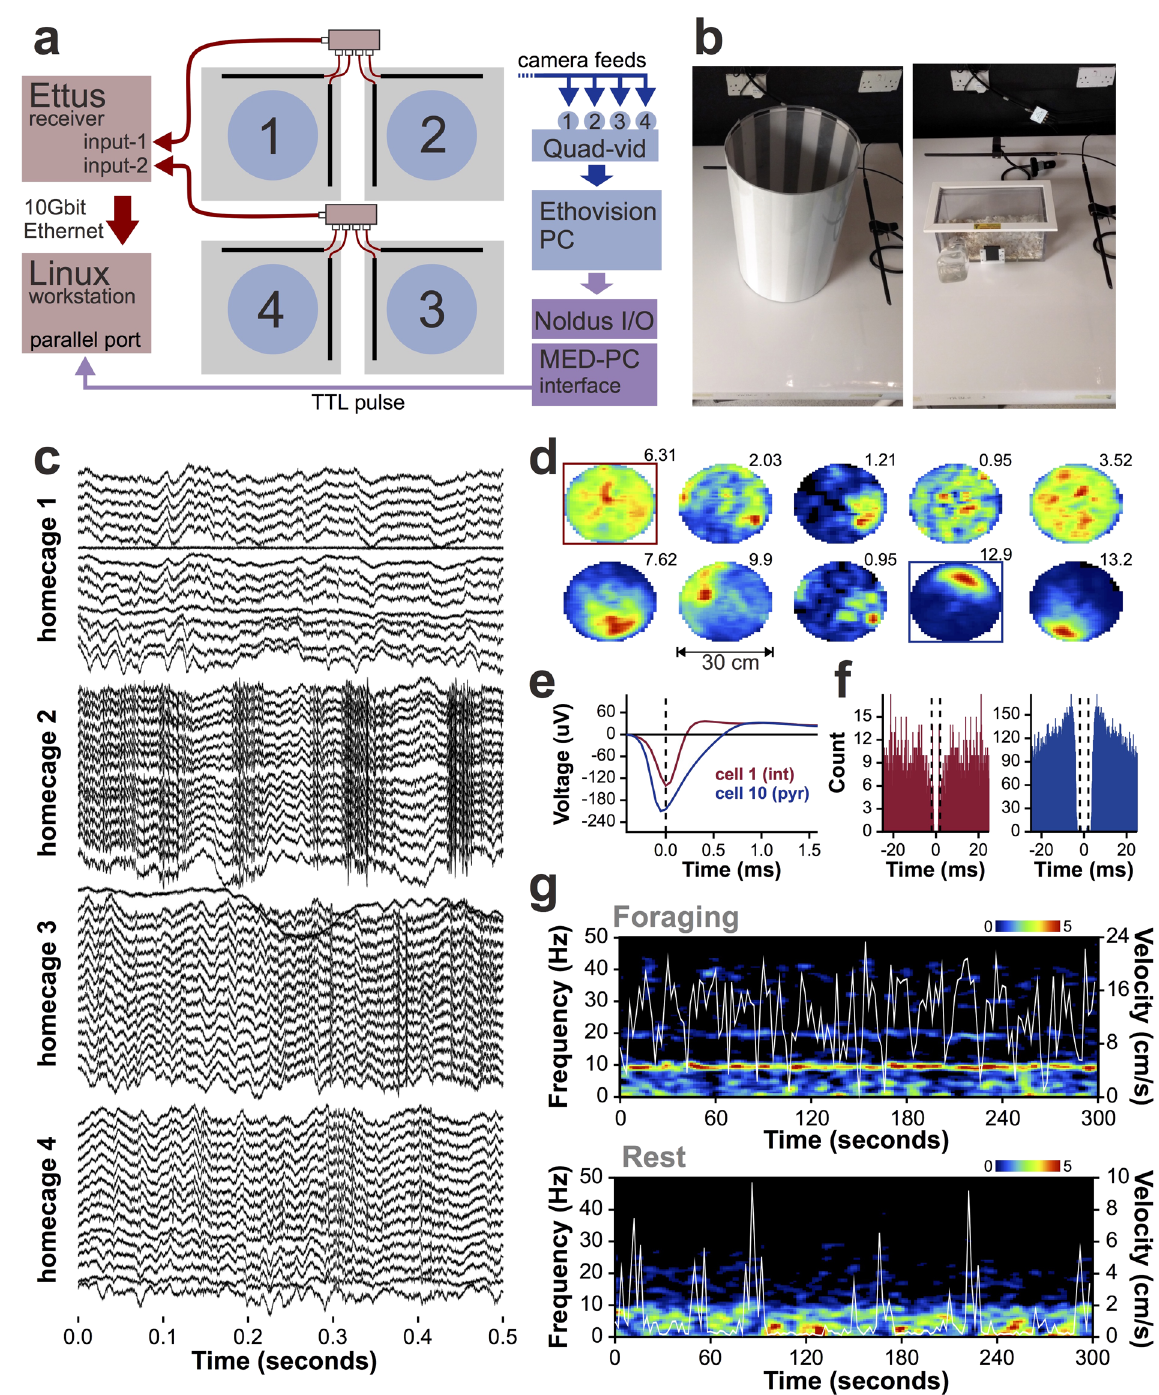
Figure 4. In vivo recordings with TaiNi. ( a ) Recording configuration diagram, illustrating integration of electrophysiological (pink/red) and behavioural (blue) data streams. Boxes in purple represent the sync-pulse pathway connecting the two systems. A separate Linux workstation and Windows PC run the TaiNi and EthoVision acquisition software, respectively. Boxes in purple represent the sync-pulse pathway connecting the two systems. Blue circles represent the pellet foraging arenas, Grey squares are the infrared tables. Black rods represent the antennas on each table, which feed to a 4-way signal-joiner. ( b ) The pellet-foraging arena (left) and the home-cage used for sleep/rest recordings (right). ( c ) Simultaneous recordings from 4 mice in the home-cages. Each mouse contributes 16 traces - one from each channel on the electrode. Local field potentials are evident in all animals. The mouse in home-cage 2 shows recordings indicative of muscular artefacts typical of chewing or scratching. Action potentials can be seen in the recordings from home-cage 4. ( d ) Spatial firing fields of 10 neurons recorded from the CA1 field of the dorsal hippocampus of one of the mice, during the pellet foraging task. Mean firing rates are indicated above each heat-map. Warm colours represent higher firing